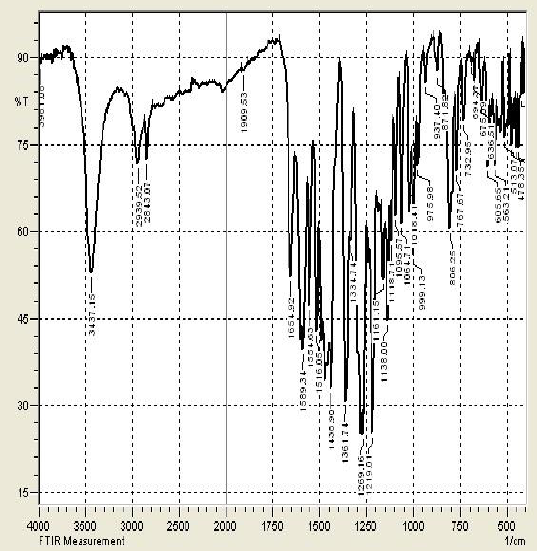
Figure 5: IR spectra of the isolated Casticin Melting Point